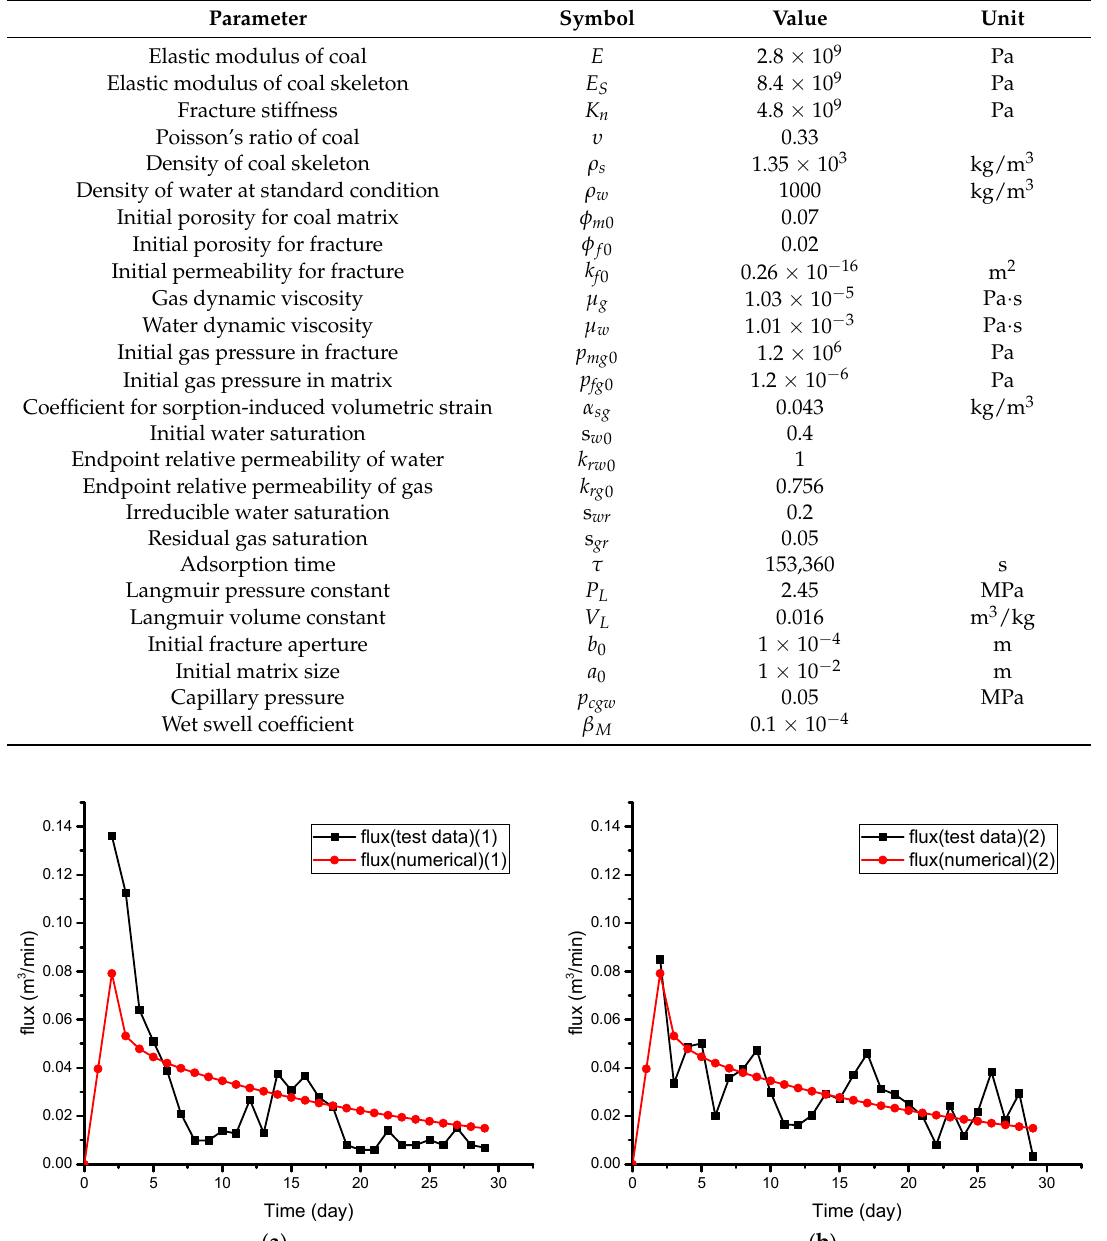
Figure 3. Comparison curves of the gas flows obtained through numerical simulation and field collection of borehole 1 ( a ) and borehole 2 ( b ).